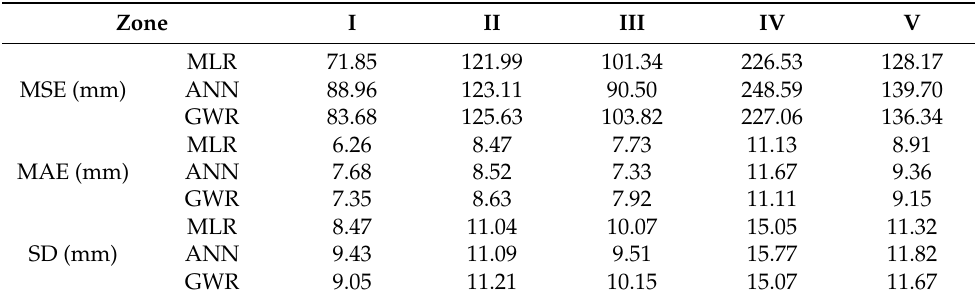
Table 2. Error test of precipitation product correction method (the shadow represents the best performing method of test index in each